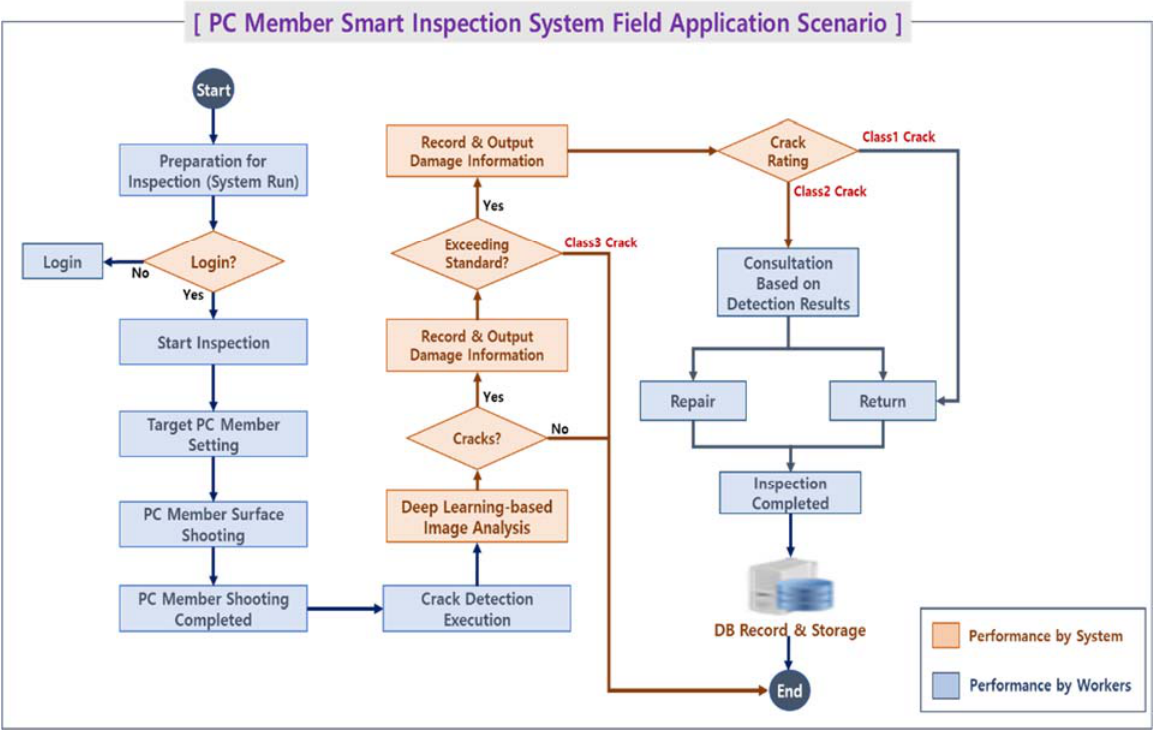
Figure 14. Field application scenario for smart quality inspection